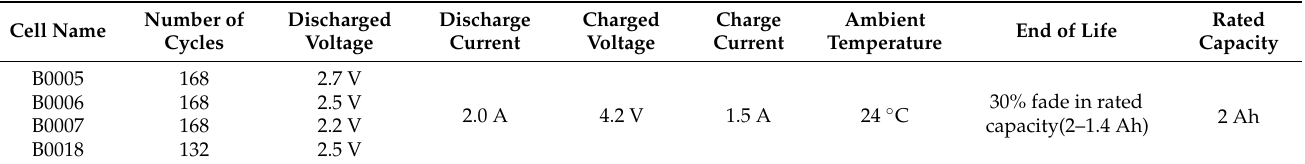
Table 1. Cell degradation test parameters.